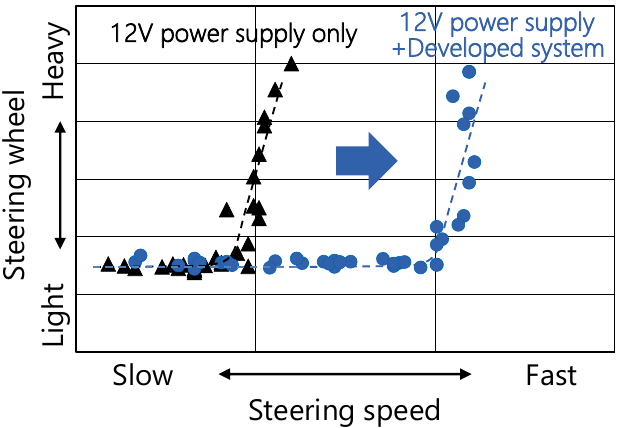
Figure 8. Comparison of torque assist responsiveness.